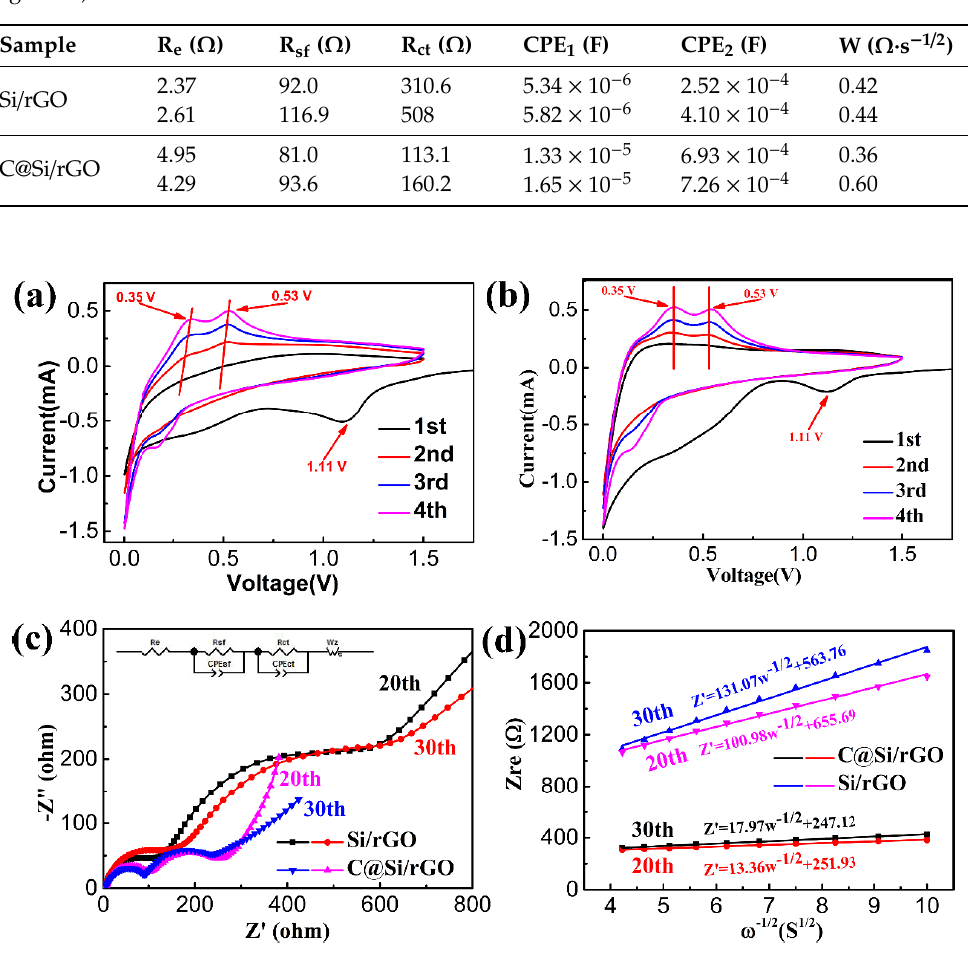
Figure 7. ( a ) Cyclic voltammetry (CV) curves of Si/rGO and ( b ) C@Si/rGO film electrode at a scanning rate of 0.5 mV s − 1 in the potential range of 0.01 – 1.5 V (vs. Li/Li + ); ( c ) Nyquist plots with